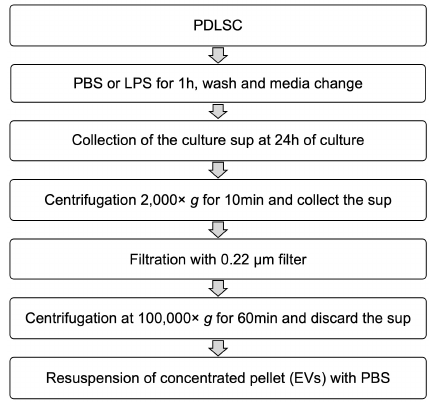
Figure 9. Schematic diagram for the isolation of EVs.